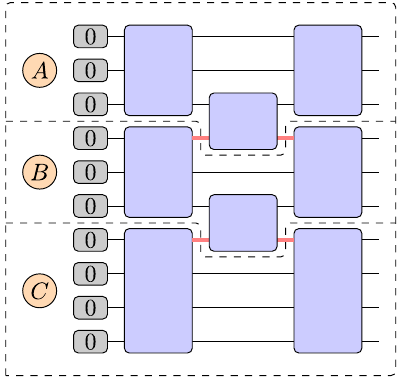
Fig. 4 Random unitary circuit (RUC) of ten qubits split into three clusters. Qubits are fi rst split among clusters as evenly as possible, and each cluster is prepared in a random state by the application of a Haar-random unitary gate 33,34 . Adjacent clusters are then entangled with random two-qubit gates, before again applying a layer of random unitaries on all clusters. A clustered RUC is cut into fragments (labeled A , B , C ) by cutting the bottom legs (shown in red) of every intercluster entangling gate.